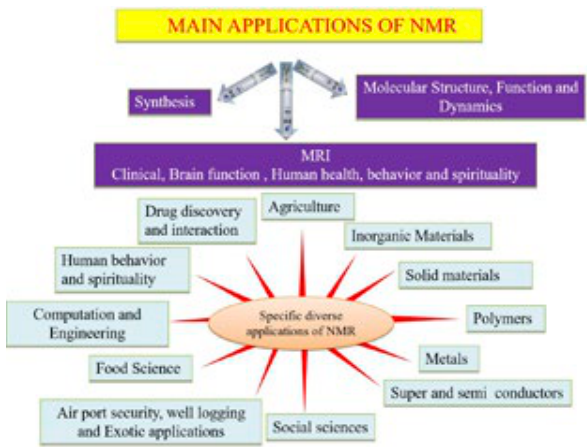
Figure 3. Major applications of NMR in different